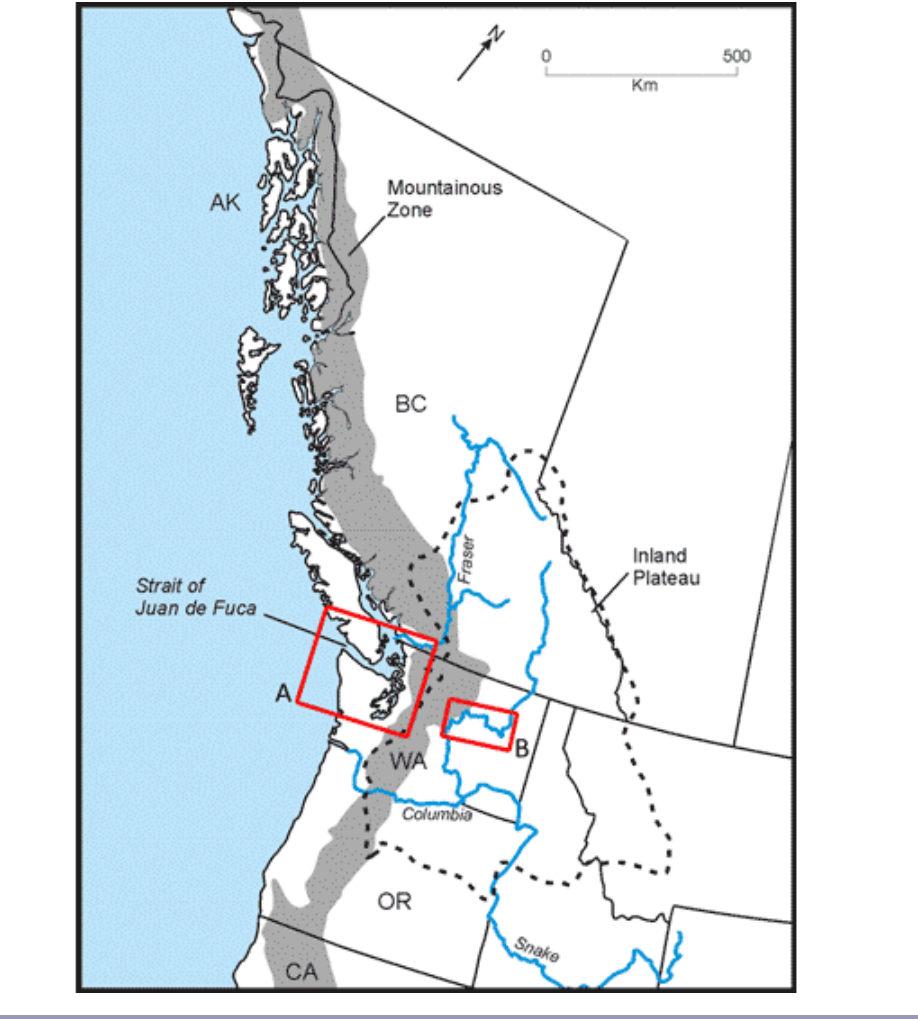
Fig. 1. Map of the Pacific Northwest, showing location of study areas: (A) south–central Northwest Coast; (B) northern Columbia